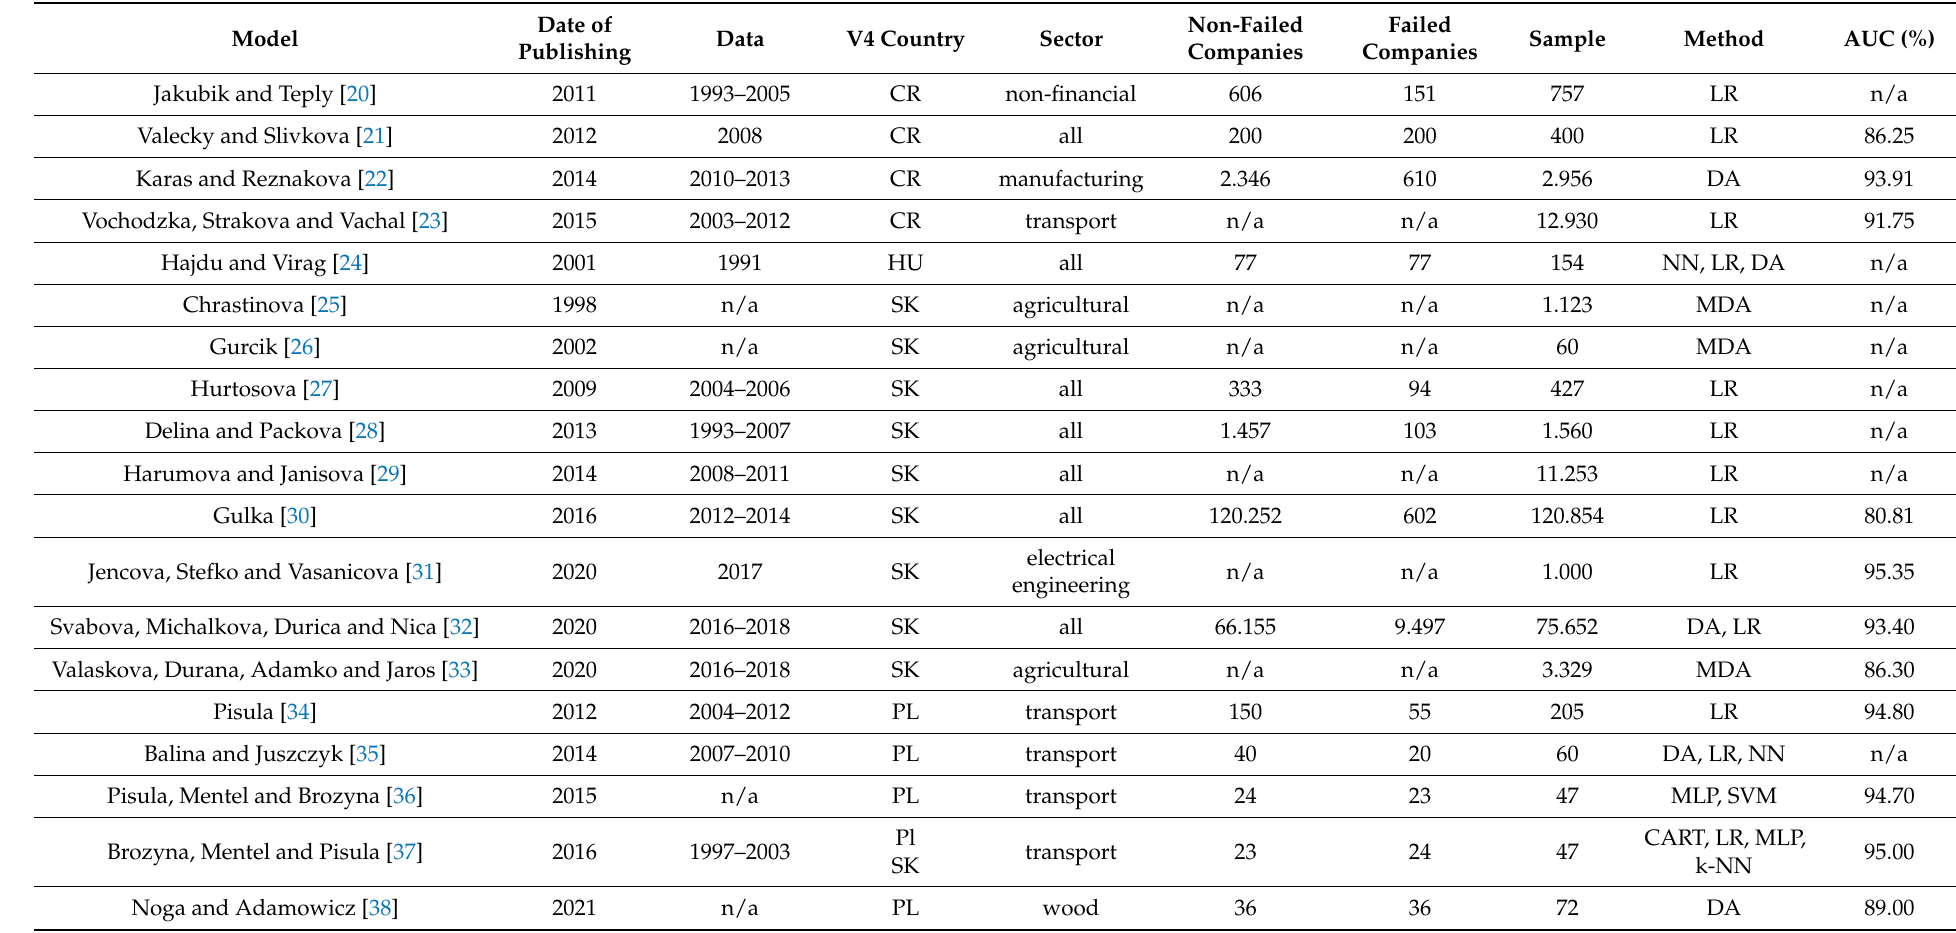
Table 1. Review of prediction models in the Visegrad